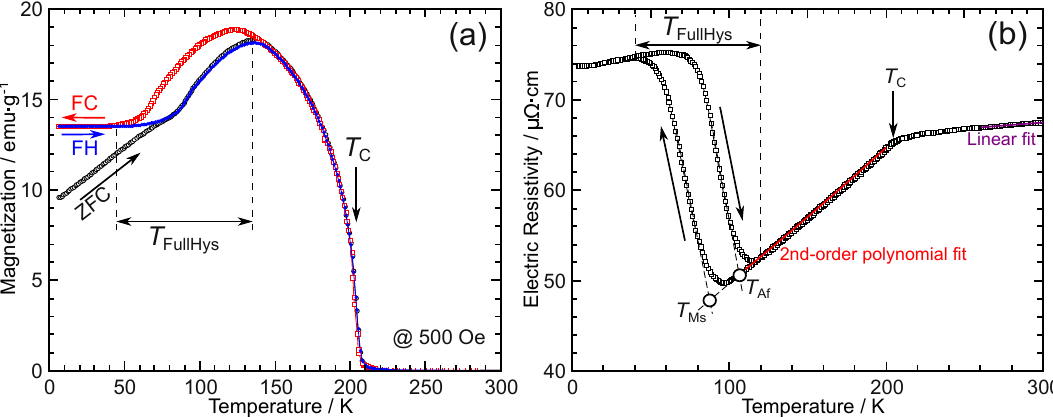
Figure 2. Results of ( a ) thermomagnetization measurements under 500 Oe and ( b ) temperature dependence of the electric resistivity of Pd 2 Mn 1.4 Sn 0.6 . In the figures, the Curie temperature is denoted as T C . In ( a ), the zero-field-cooling (ZFC), field-cooling (FC), and field-heating (FH) measurements are presented. In ( b ), T M and T A indicate the martensitic transformation starting and reverse s f transformation finishing temperatures, respectively, with T FullHys indicating the full thermal hysteresis of the thermoelastic martensitic transformation. For the parent phase, linear and second-order polynomial fits are conducted for the temperature ranges above and below the T C , respectively. Refer to the text for